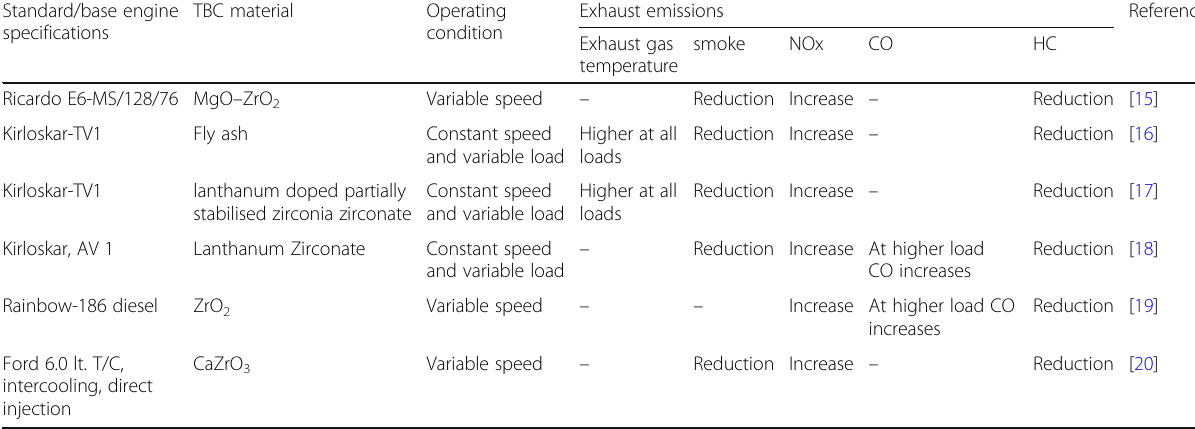
Table 1 LHR engine exhaust emission compared to conventional engine fueled with biodiesel using plasma spray coating